Question: Name the type of graph shown.
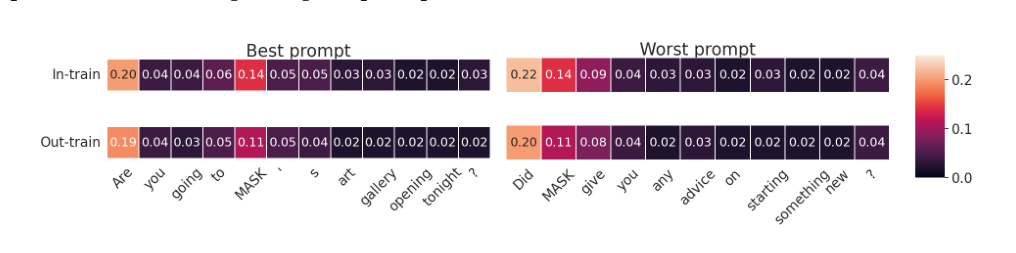
Answer: heatmap